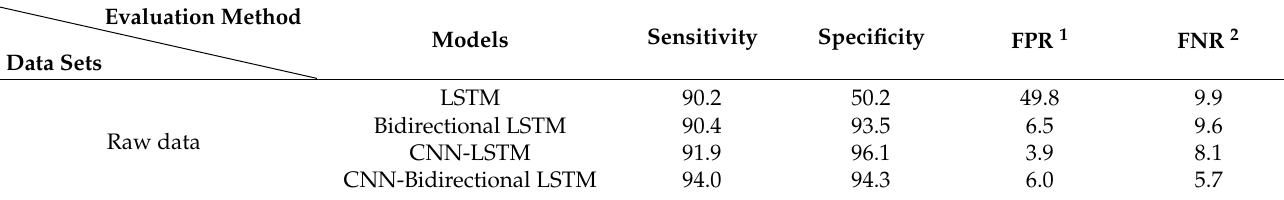
Table 4. DL models’ sensitivity, specificity, FPR, and FNR based on raw values. SetsEvaluation Data